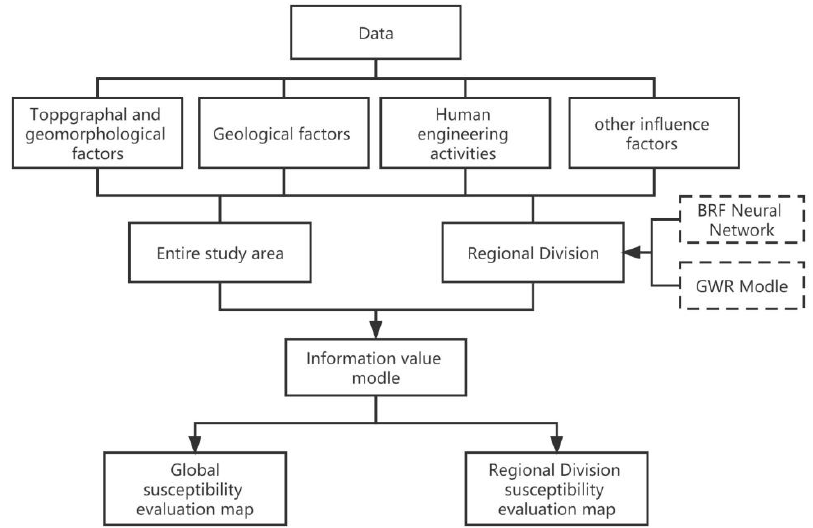
Figure 2. Flowchart of the methodology used in this study.